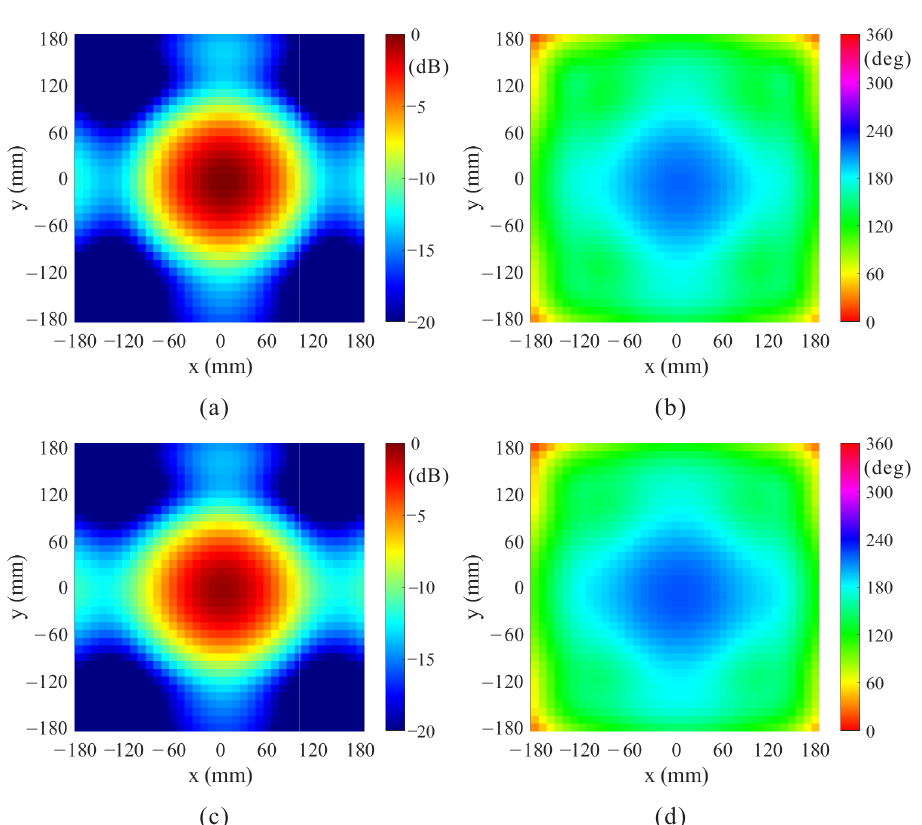
Figure 8. Near-field distribution when applying uniform excitation to ports: ( a ) simulated amplitude, ( b ) simulated phase, ( c ) measured amplitude, and ( d ) measured